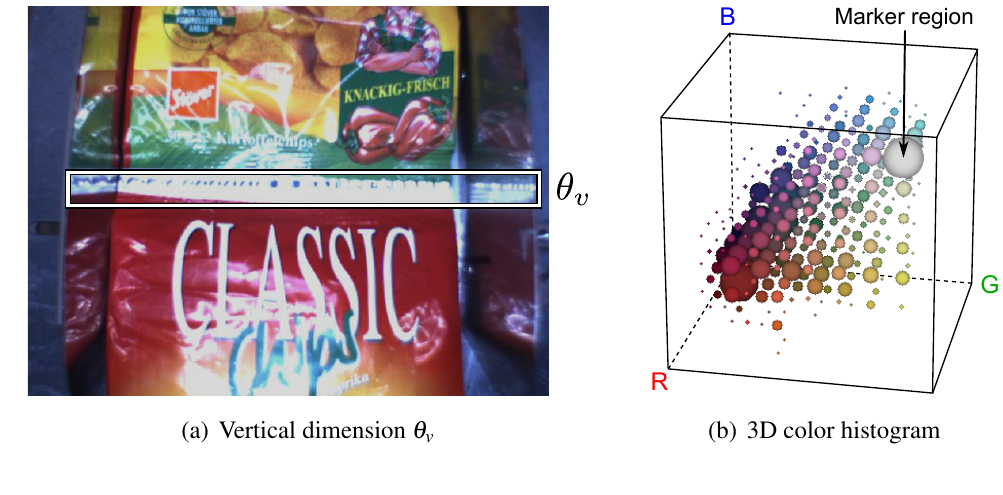
Figure 9. Model of the color based marker depending on the ( a ) vertical image dimension θ v of the marker and ( b ) the three dimensional RGB histogram. The size of the spheres symbolizes the pixel count in the